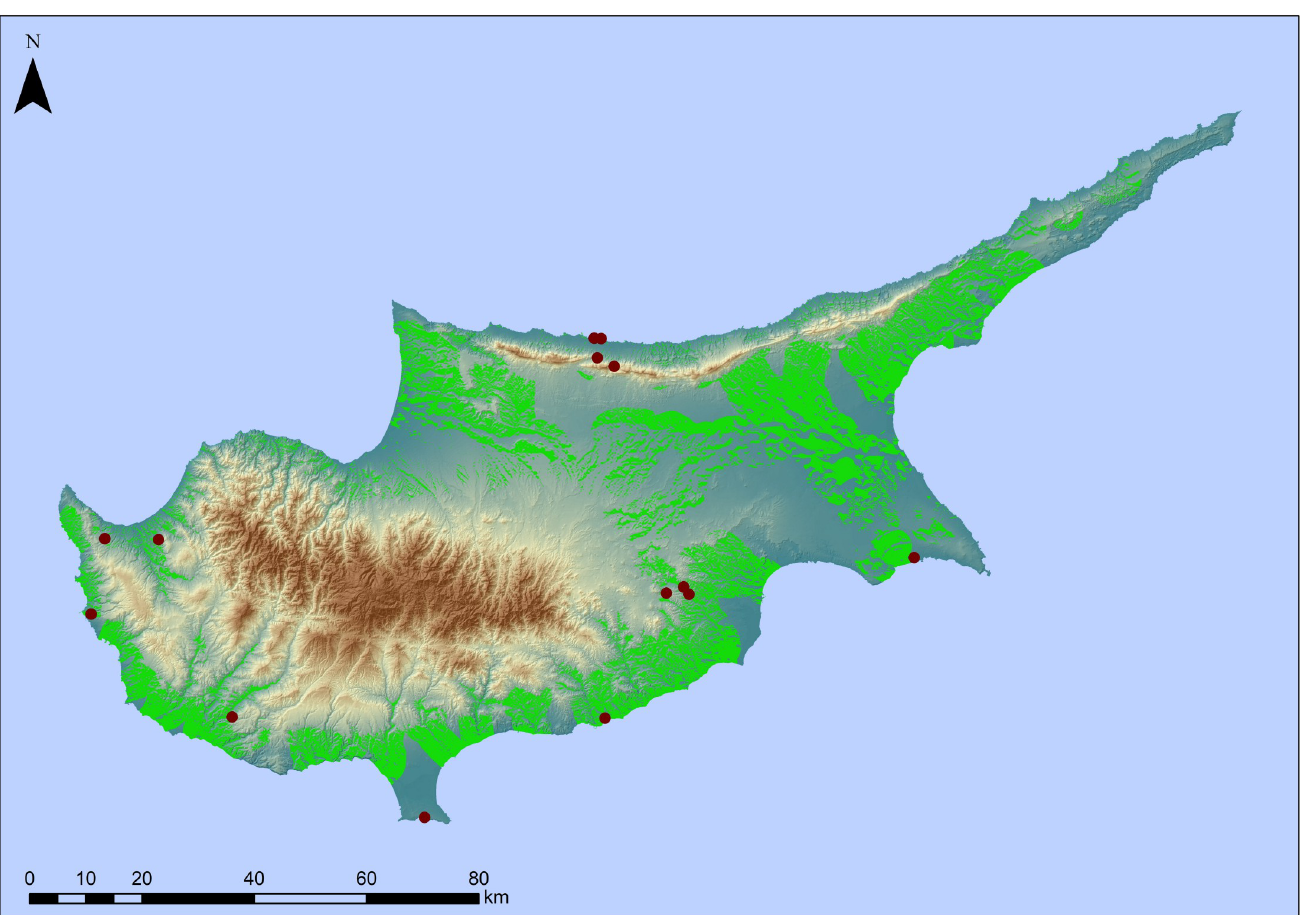
Fig 4. Prediction map of high probability areas for Pleistocene archaeological sites on Cyprus. Prediction map delineating high probability areas for the location of potential Pleistocene archaeological sites on Cyprus based on attractive topographic attributes. The dark red dots represent known early archaeological sites on Cyprus (see Fig 1 for site names). Note how all but one archaeological sites fall within the high probability zone (green area) as defined by the predictive model. Original copyright with the authors.